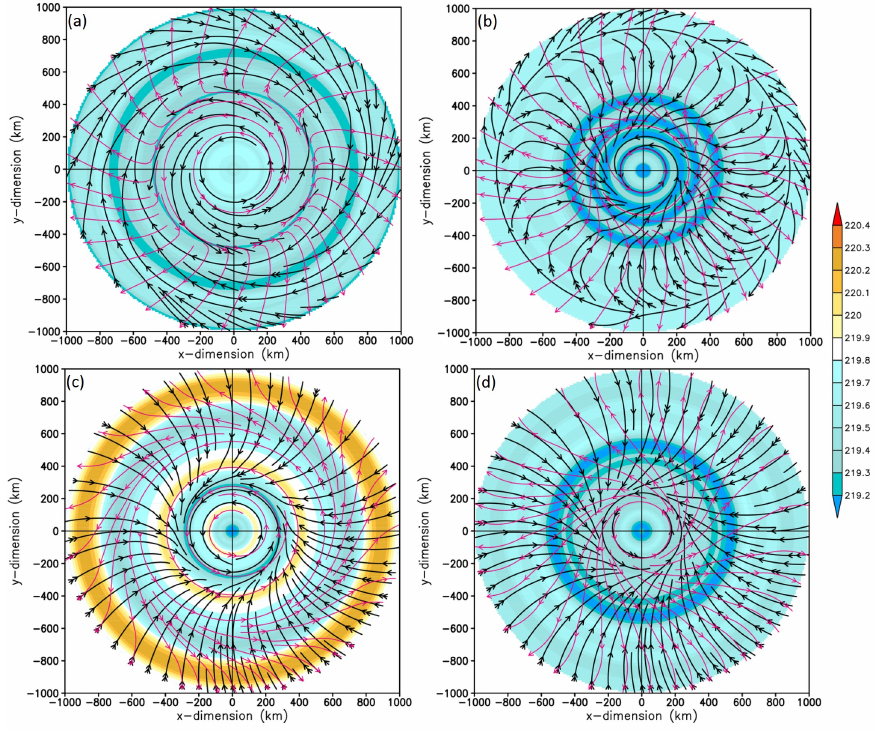
Figure 7. Horizontal cross sections of the mean temperature (shaded, K) averaged within a 75–50 hPa layer, and overlaid streamlines representing the upper-level inflow (black lines) in the same layer valid at t = 5 days into integration for ( a ) NATL-CTL experiment; ( b ) WPAC-CTL experiment; ( c ) NATL-RH switching experiment; and ( d ) WPAC-RH switching experiment. Red streamlines denote the outflow averaged within the 150–100 hPa